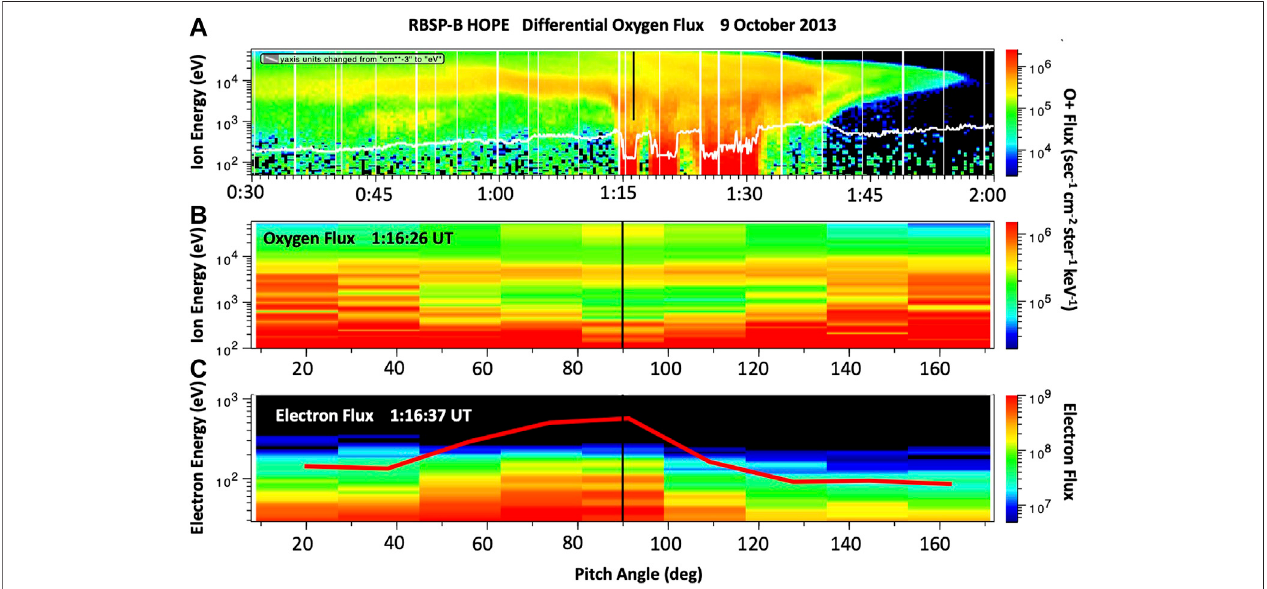
FIGURE 7| RBSP-B O+ fl ux observations are plotted from HOPE data for the inbound orbit, showing acrossing of the outer boundary of the plume multiple times beginningat ∼ 01:15 UTonOctober9,2013. (A) Ateachcrossing,strongO+ fl uxeswithenergies10 eVto > 5 keVcharacterizedtheregionimmediatelybeyondtheedge oftheplume. Insitu EFWmeasurementsofcoldplasmadensity areshownbythewhitecurve. (B) O+PADsat theedgeoftheplume areshownforthetime indicatedby the fi ducialblacklinein Figure5A . (C) HOPE electronPADsindicate down fl owingelectron fl uxesatenergies upto300 eV.ThePADfor105 eVelectrons isshown as the red curve (black fi ducial line indicates 90 ° pitch